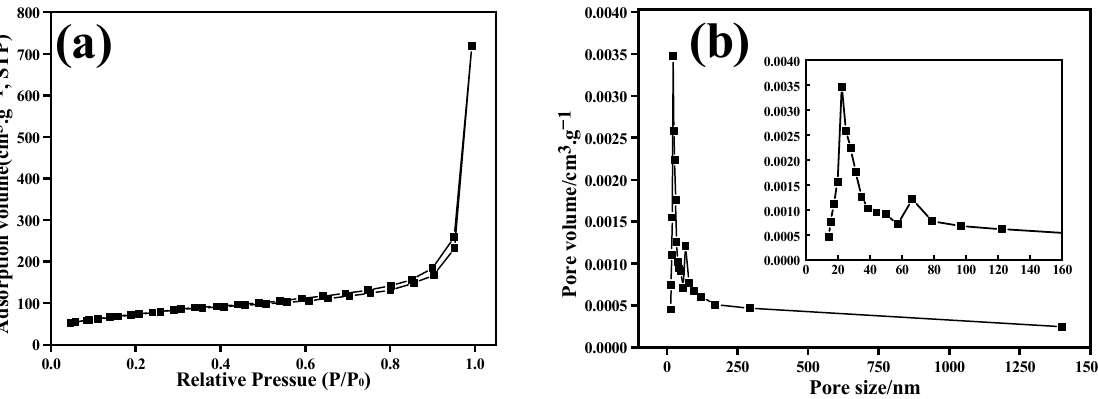
Figure 8. ( a ) N 2 adsorption–desorption isotherms. ( b ) Pore size distributions.